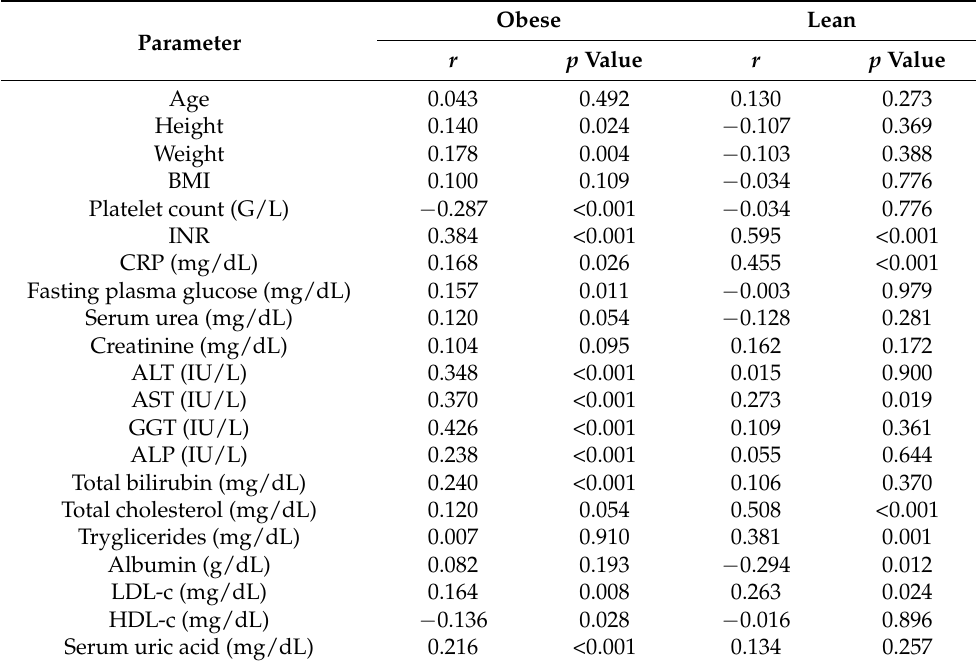
Table 2. Parameters associated with the presence of